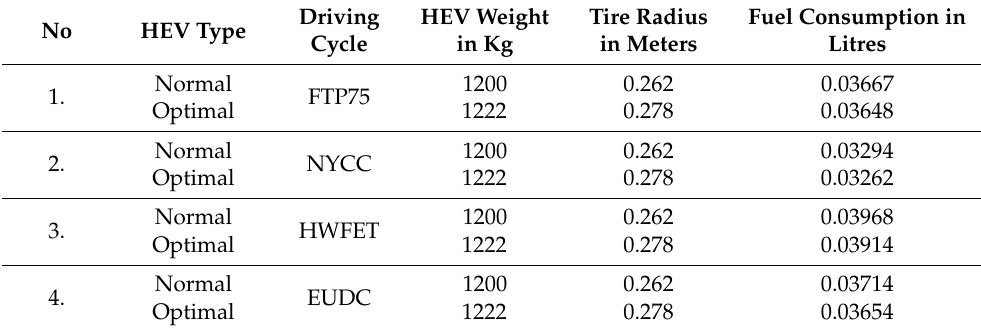
Table 5. Compared fuel consumption of optimal vs. normal HEVs.